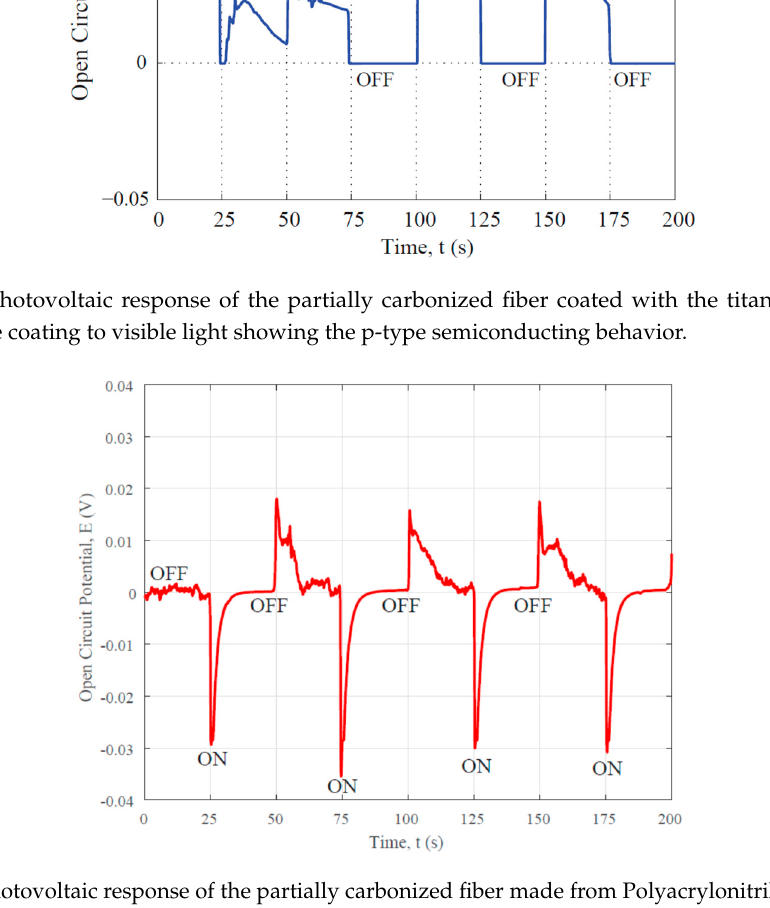
Figure 7. Photovoltaic response of the partially carbonized fiber made from Polyacrylonitrile (PAN) to the visible light showing the n-type semiconducting behavior.